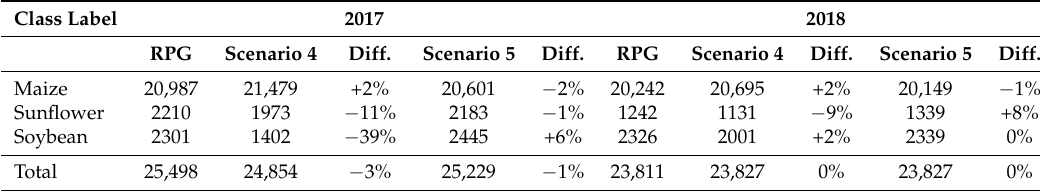
Table 8. Summary of areas by class for Scenarios 4 and 5 and the RPG for the years 2017 and 2018. They are expressed in hectares. The term diff. refers to the difference between the area from the scenario and the RPG. It is expressed as a